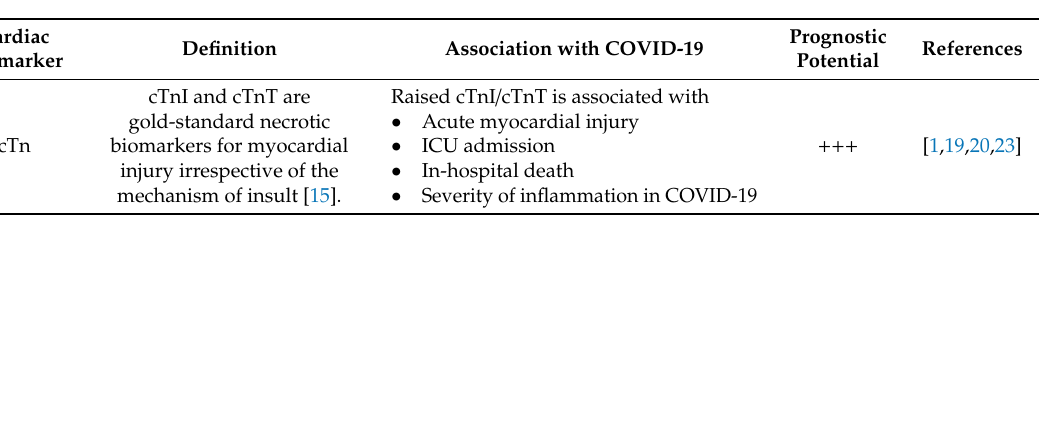
Table 1. A table highlighting the biomarkers of myocardial injury that may have prognostic value in the coronavirus disease